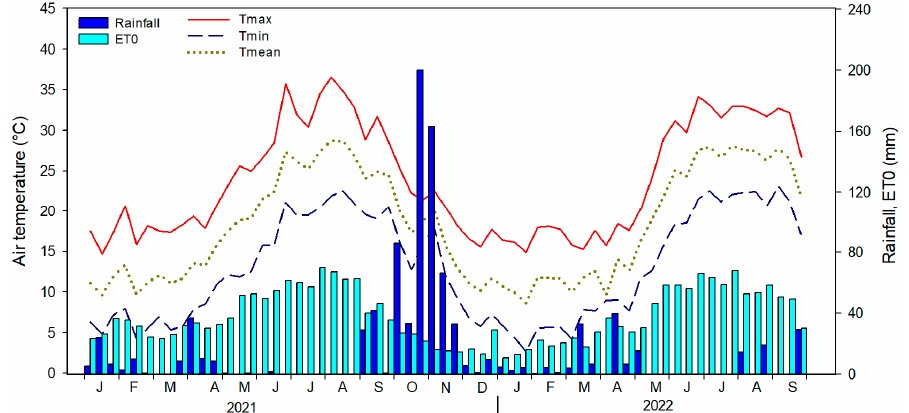
Figure 1. Meteorological course (air temperature, rainfall, and reference evapotranspiration–ET 0 ) recorded during the 2-year period (2021–2022) at the experimental farm of the University of Catania, Italy (10 m a.s.l., 37°25 ′ N lat., 15°03 ′ E long.).